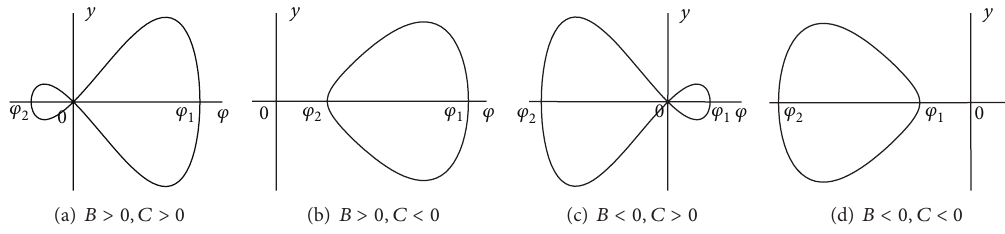
Figure 3: The bifurcation phase portraits of system (6) with 𝐴 < 0